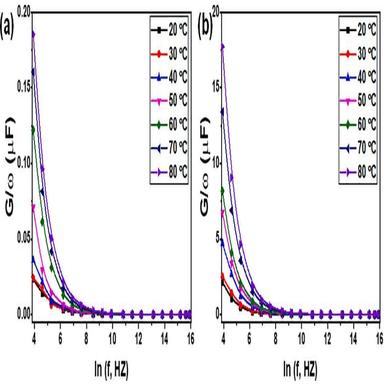
G/ω–f curves for (a) pure PVA and (b) PVA/Gr-7 wt% NQNs at various temperatures ranging from 20 ◦C to 80 ◦C. The conductance was measured at an applied voltage of 1 V across a frequency range from 50 Hz to 8 MHz.